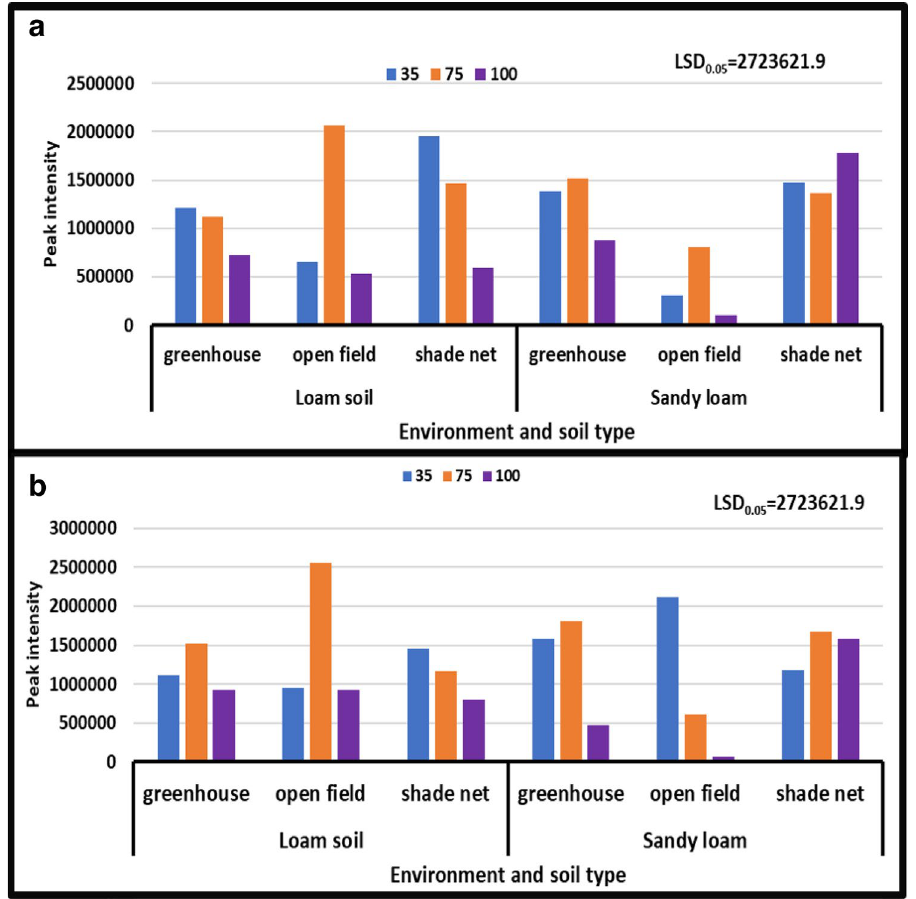
Figure 8. Treatment interaction effect on Norepinephrine of African horned cucumber fruit. 35 means severe water stress; 75 means moderate water stress; 100 means no water stress; ( a ) means treatment interaction of water stress levels and soil types at different growing environments during the 2017/18 season; ( b ) means treatment interaction of irrigation water levels and soil types at different growing environments during the 2018/19 season. Values are average over treatment. Peak intensity showing LCMS-8040 triple quadrupole mass spectrometer intensities which represent the quantity of metabolites varying with treatments. LSD 0.05 is the least significant difference of